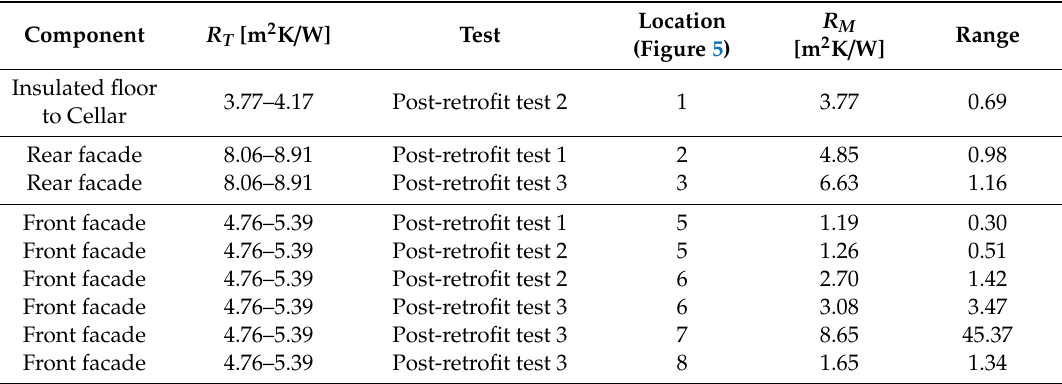
Table 8. Measured thermal